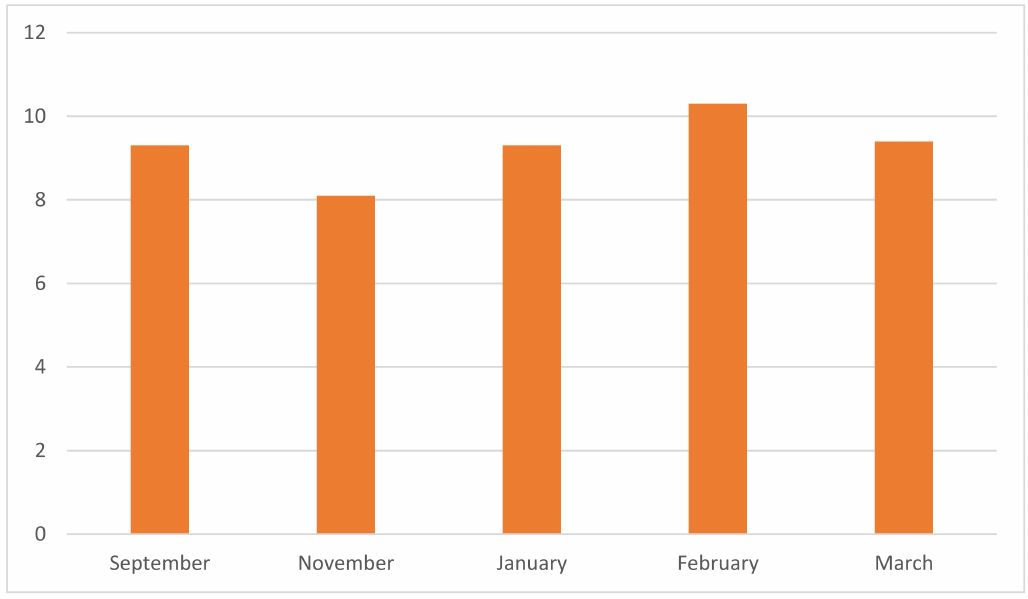
Figure 2. Fear of COVID-19 Scale ( n =